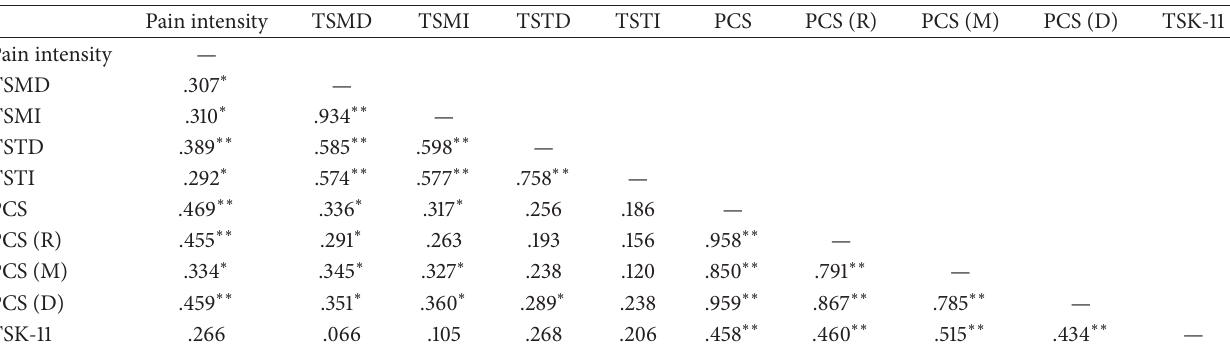
Table 3: Spearman correlation coefficient between variables.